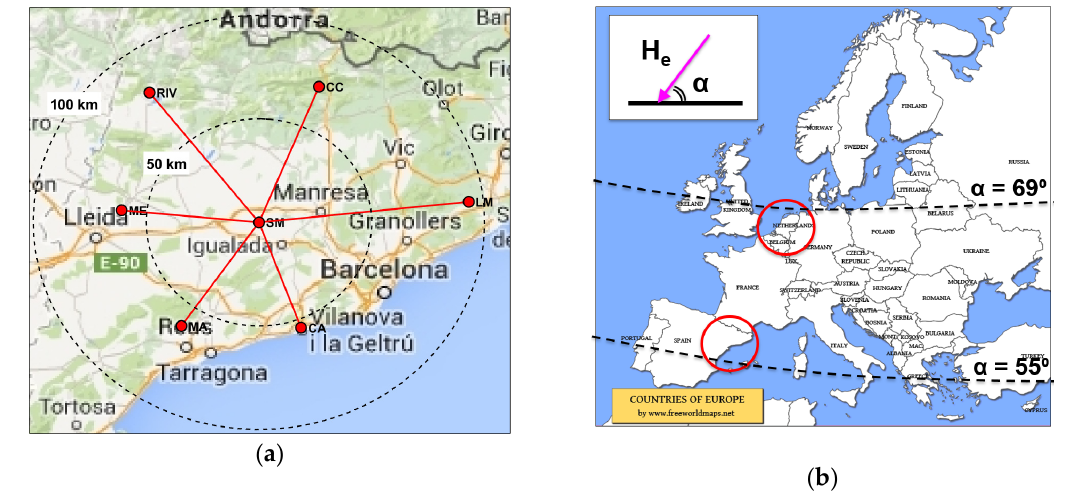
Figure 3. Experiment topology: ( a ) An example of a star-shaped deployment (Catalonia, Spain); ( b ) The inclination of the Earth’s magnetic field changes with latitude. Map courtesy of Free World Maps.